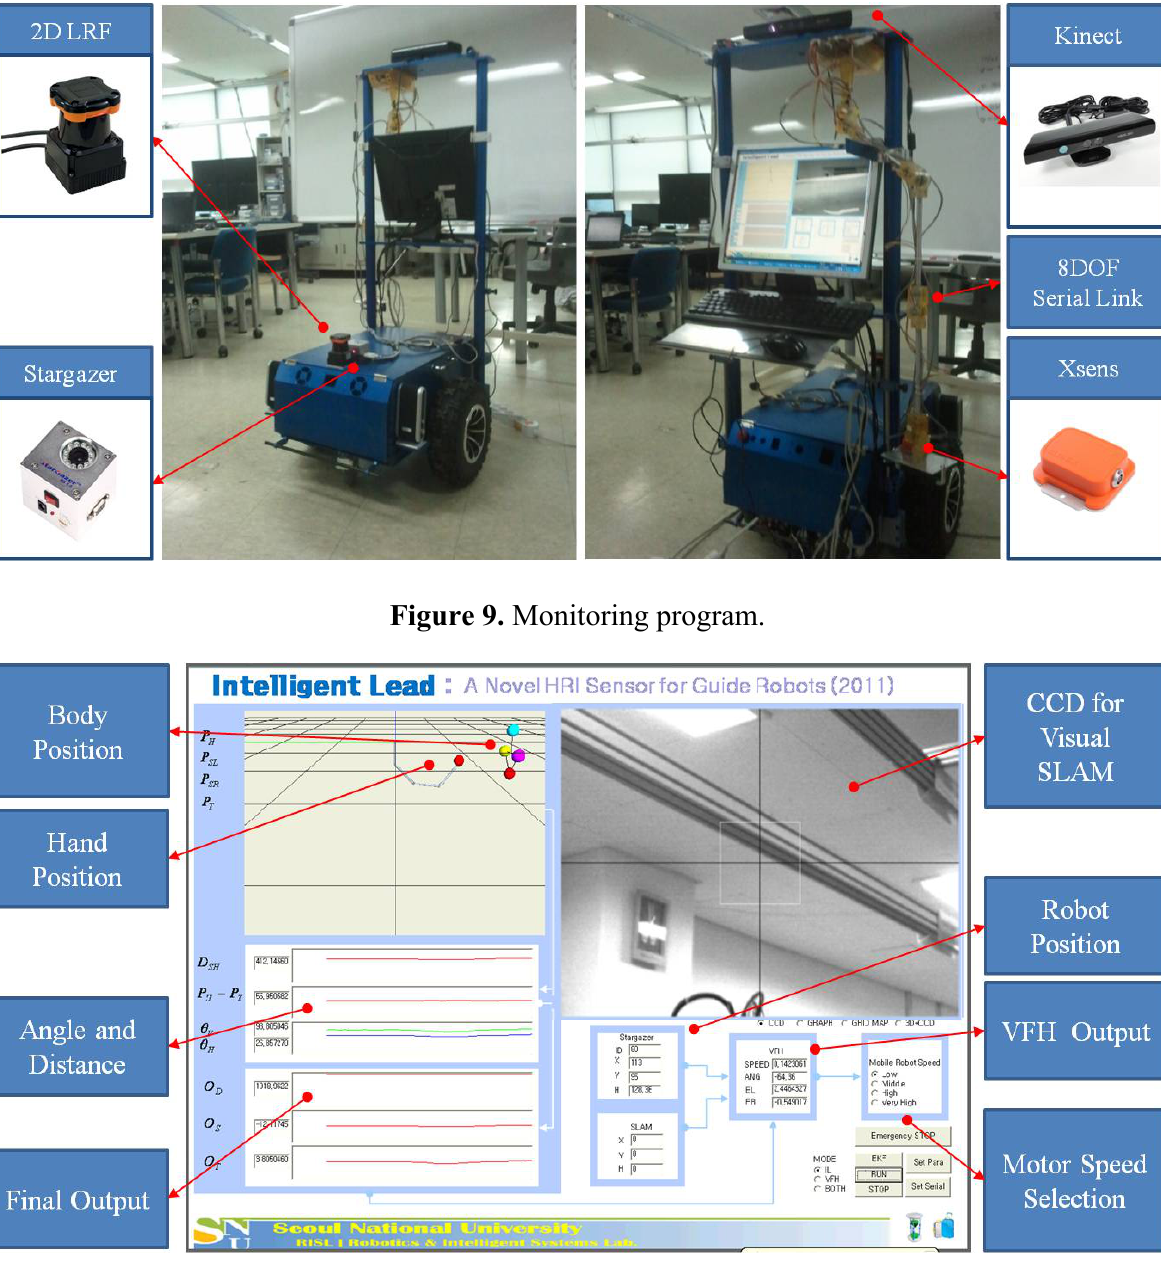
Figure 8. Experimental system.